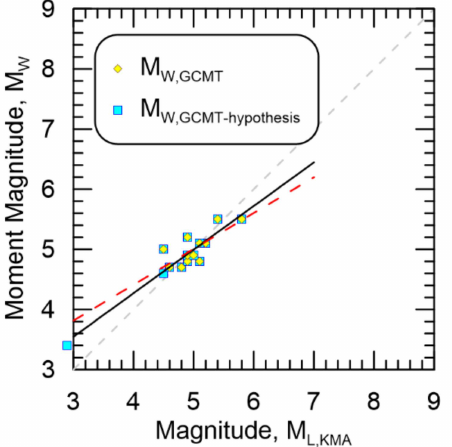
Figure 14. Resultant magnitude homogenization regressions for M W,GCMT-hypothesis against M L,KMA . Data from M W,GCMT are also shown. Black line is the regression against M W,GCMT-hypothesis while the dashed red line is the regression against M W,GCMT